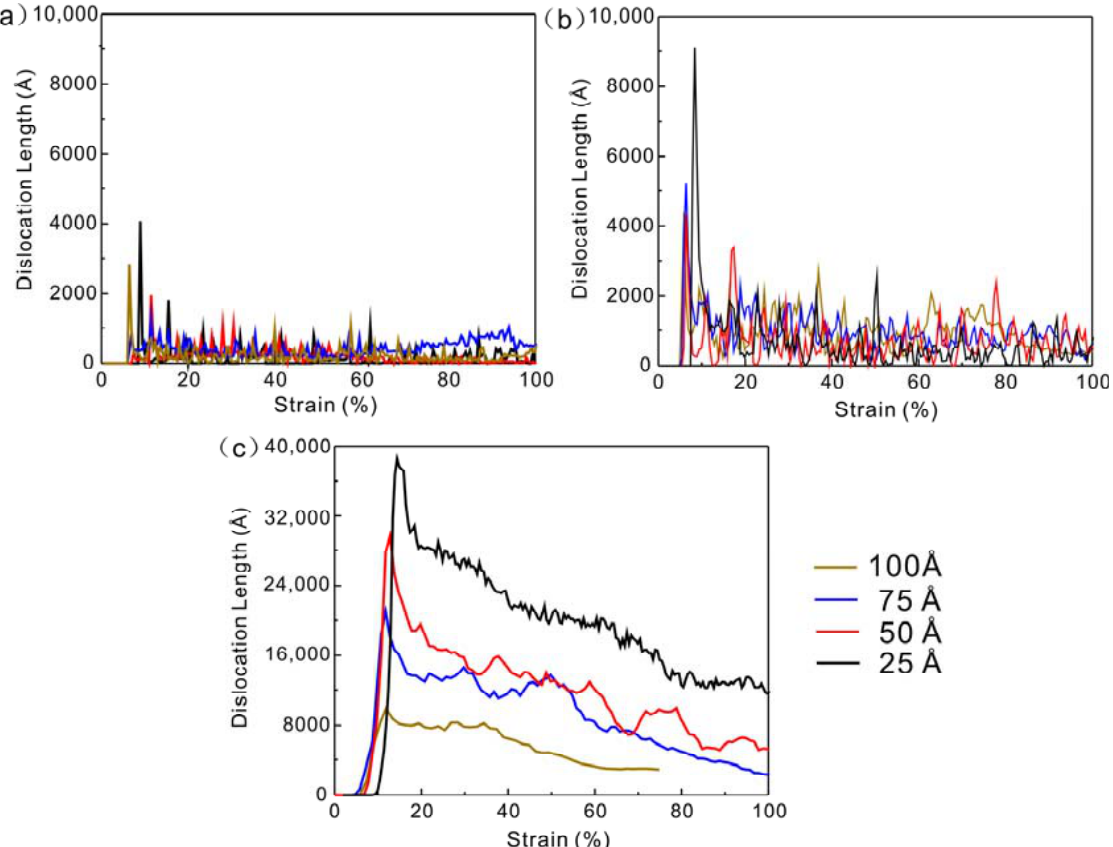
Figure 10. The variation of dislocation length with strain at di ff erent strain rates. ( a ) 1 (cid:3400) 10 (cid:2876) s (cid:2879)(cid:2869) , ( b ) 5 (cid:3400) 10 (cid:2876) s (cid:2879)(cid:2869) , ( c ) 5 (cid:3400) 10 (cid:2877) s (cid:2879)(cid:2869)